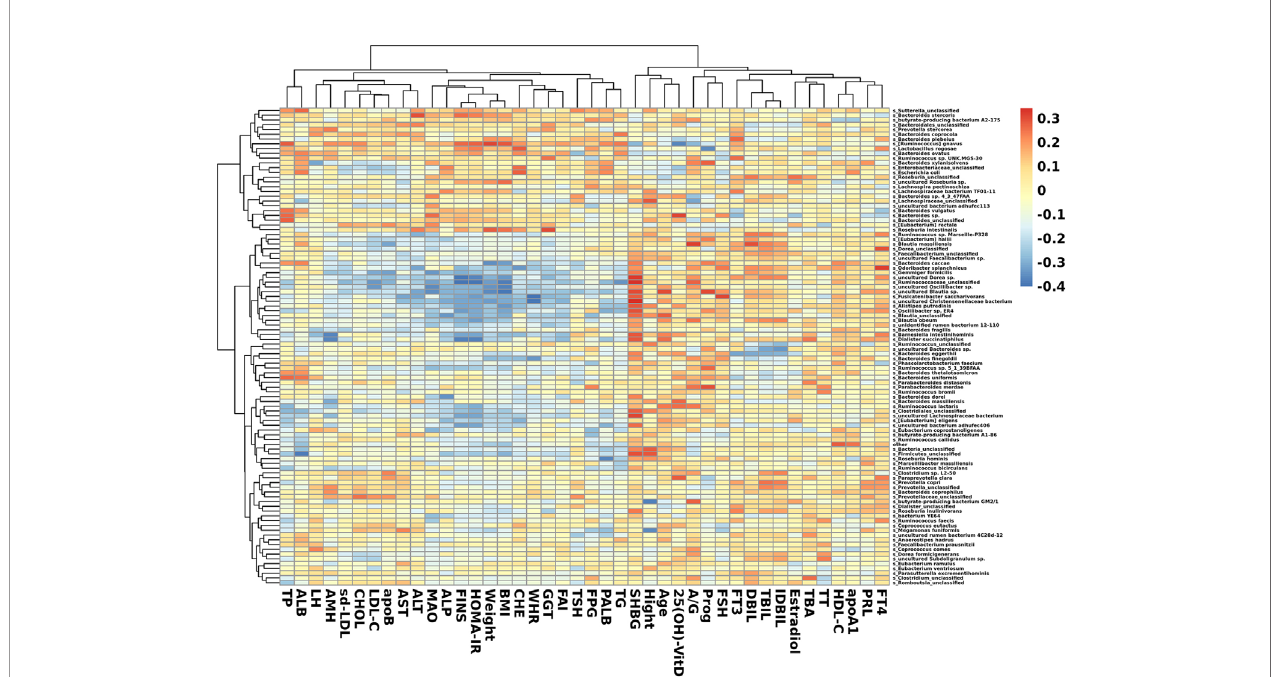
FIGURE 5 | Heatmap of correlation between clinical indexes and species. Species with the top 100 abundances that were detected in samples are listed on the left, and clinical indexes are shown on the bottom. Abundances of species are shown by different